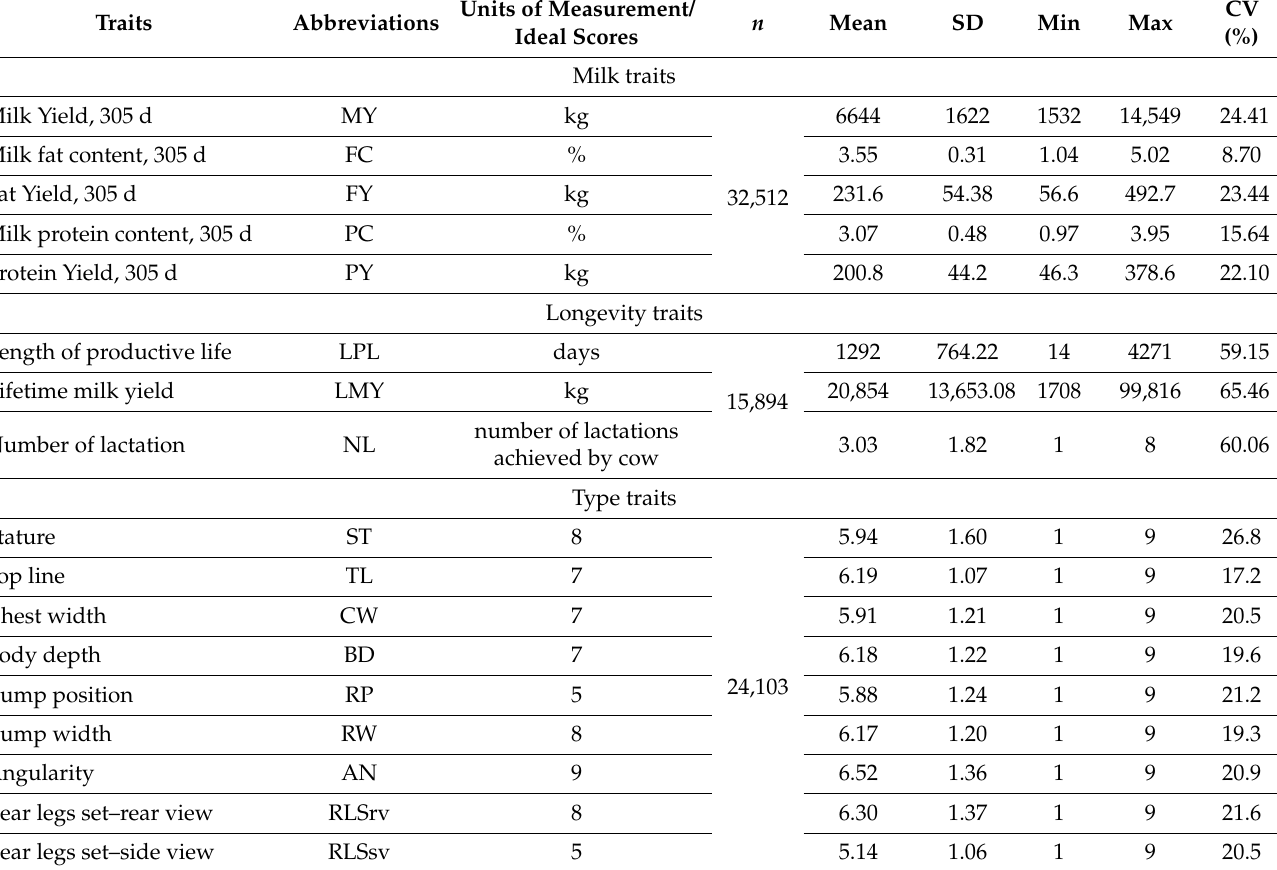
Table 1. Traits analyzed: abbreviation, units of measurement, ideal score, and descriptive statistics for milk trait, longevity traits, and type